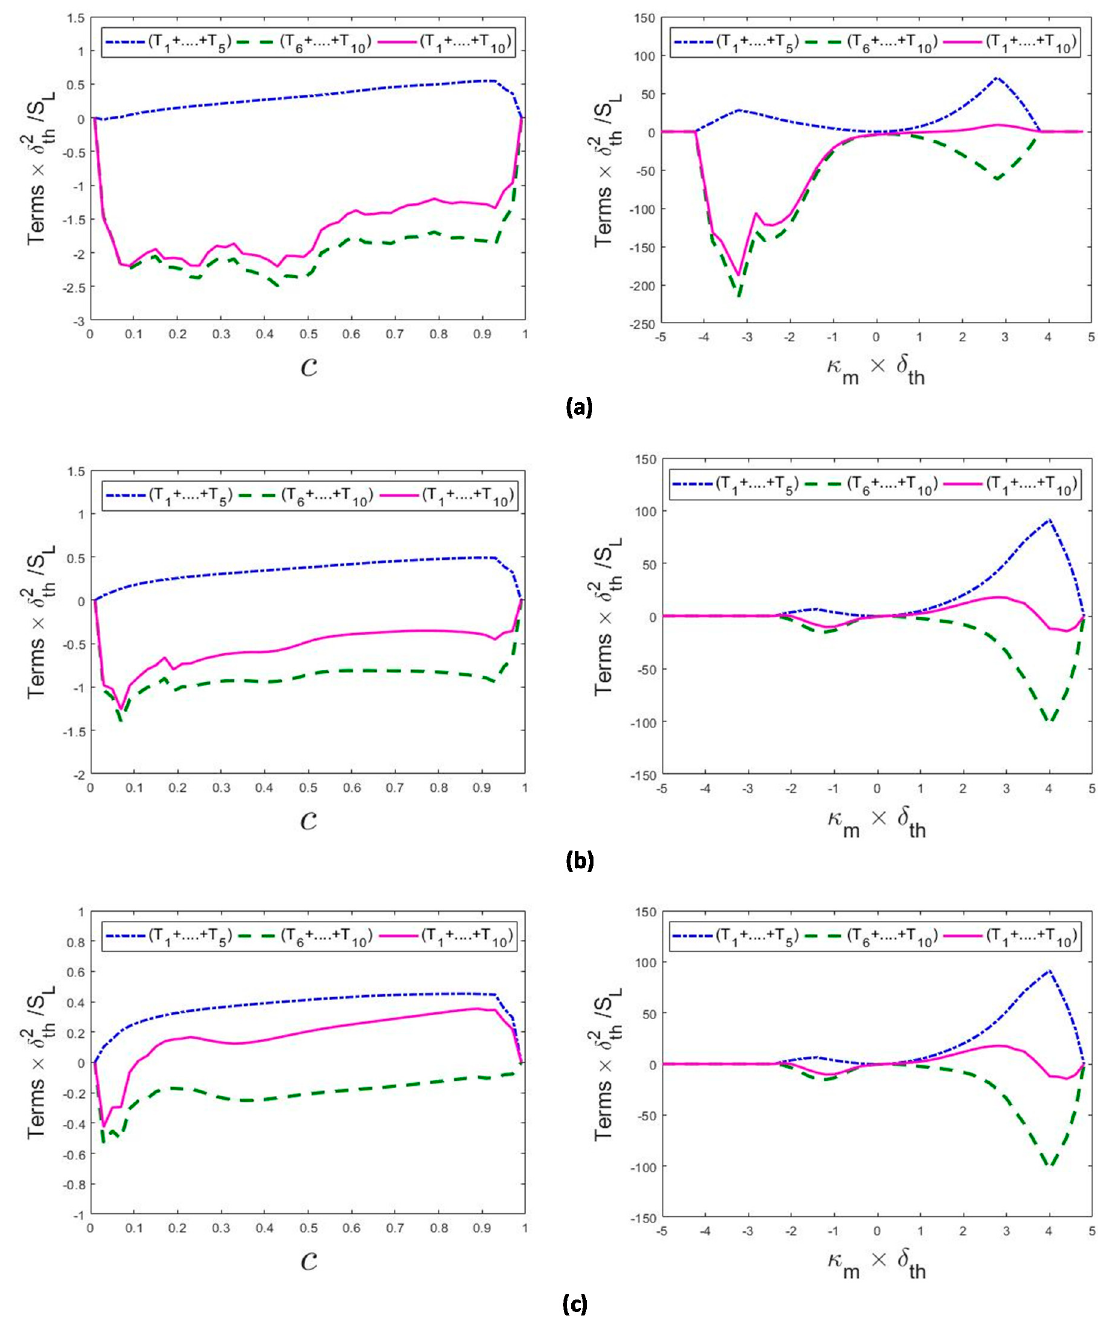
Figure 6. Profiles of normalised mean values of the flow contributions (𝑇 (cid:2869) + ⋯ + 𝑇 (cid:2873) ) × (cid:3435)𝛿 (cid:3047)(cid:3035)(cid:2870) /𝑆 (cid:3013) (cid:3439) , flame propagation induced contributions (𝑇 (cid:2874) + ⋯ + 𝑇 (cid:2869)(cid:2868) ) × (cid:3435)𝛿 (cid:3047)(cid:3035) (cid:2870) /𝑆 (cid:3013) (cid:3439) and the total contribution (𝑇 (cid:2869) + ⋯ + 𝑇 (cid:2869)(cid:2868) ) × (cid:3435)𝛿 (cid:3047)(cid:3035)(cid:2870) /𝑆 (cid:3013) (cid:3439) to the curvature transport, conditioned on the reaction progress variable 𝑐 (left column) and normalised curvature 𝜅 (cid:3040) × 𝛿 (cid:3047)(cid:3035) on the 𝑐 = 0.8 isosurface (right column) for cases ( a – c ) Le = 0.8, 1.0 and 1.2.